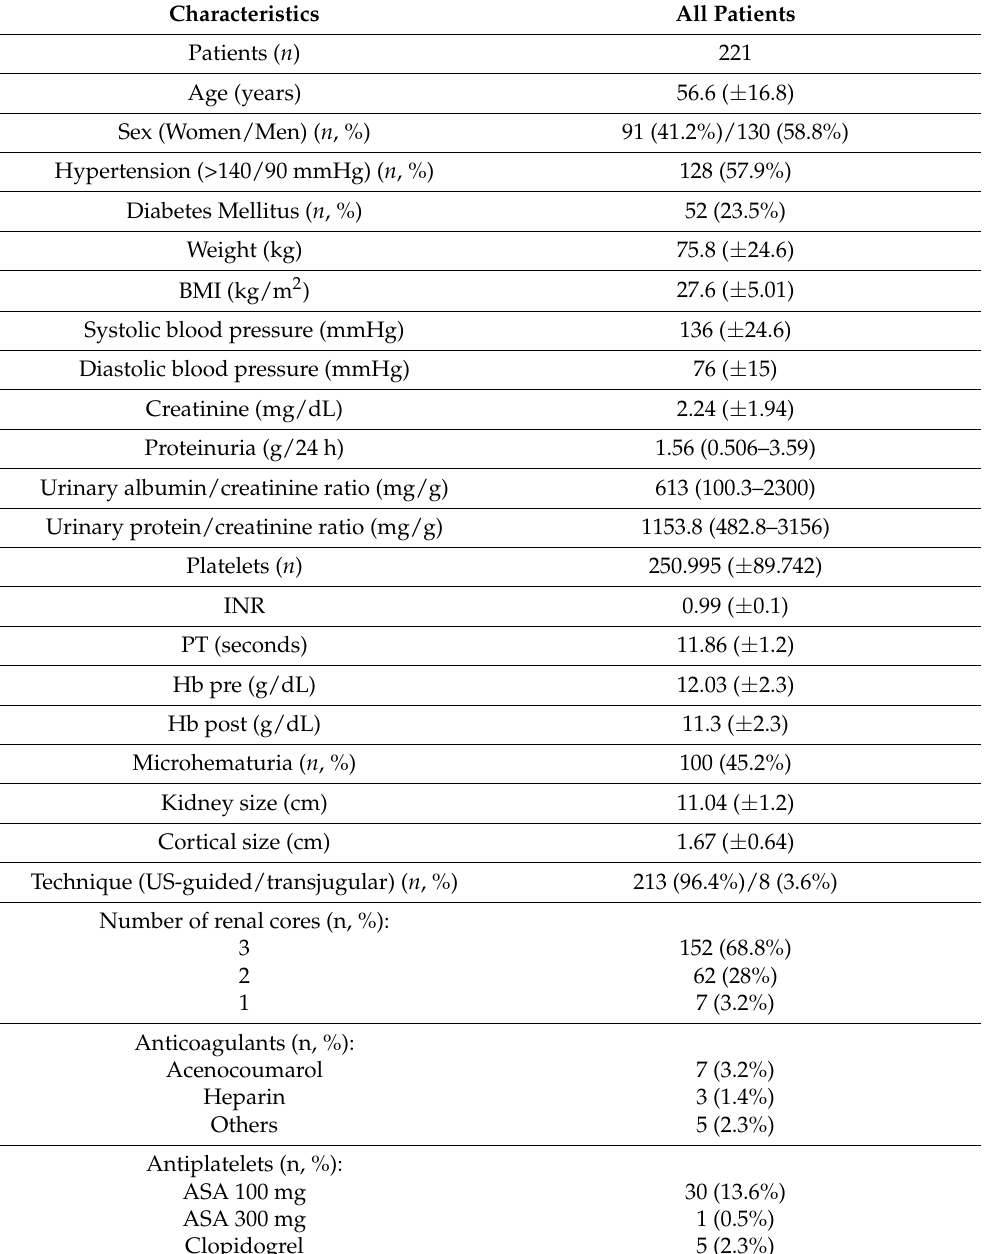
Table 2. Baseline characteristics of